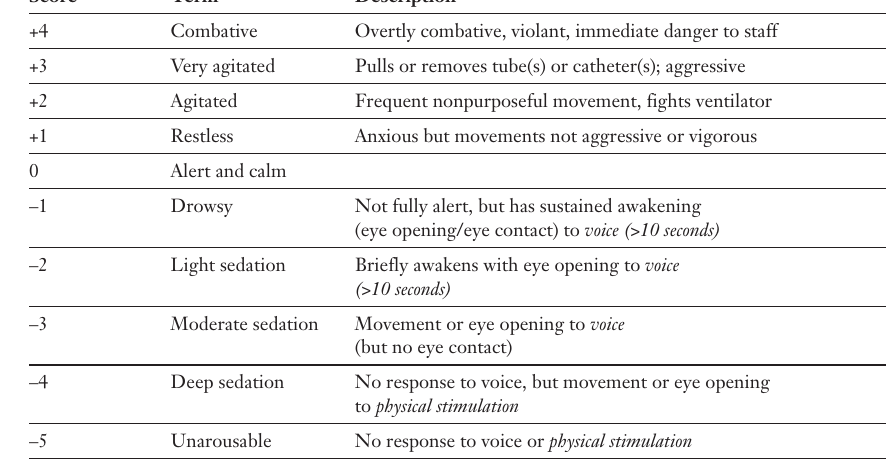
The Richmond agitation-sedation scale